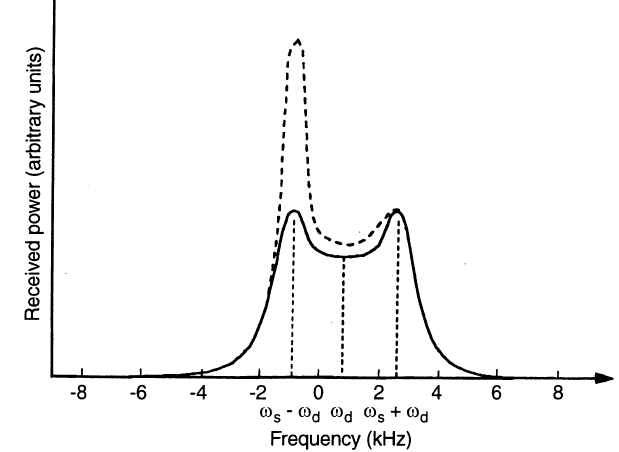
Fig. 2. Theoretical incoherent scatter spectra: classical double- humped shape ( solid line ) and distorted shape due to ion acoustic fluctuations ( dashed line ) ! d is the Doppler shift and ! s the ion